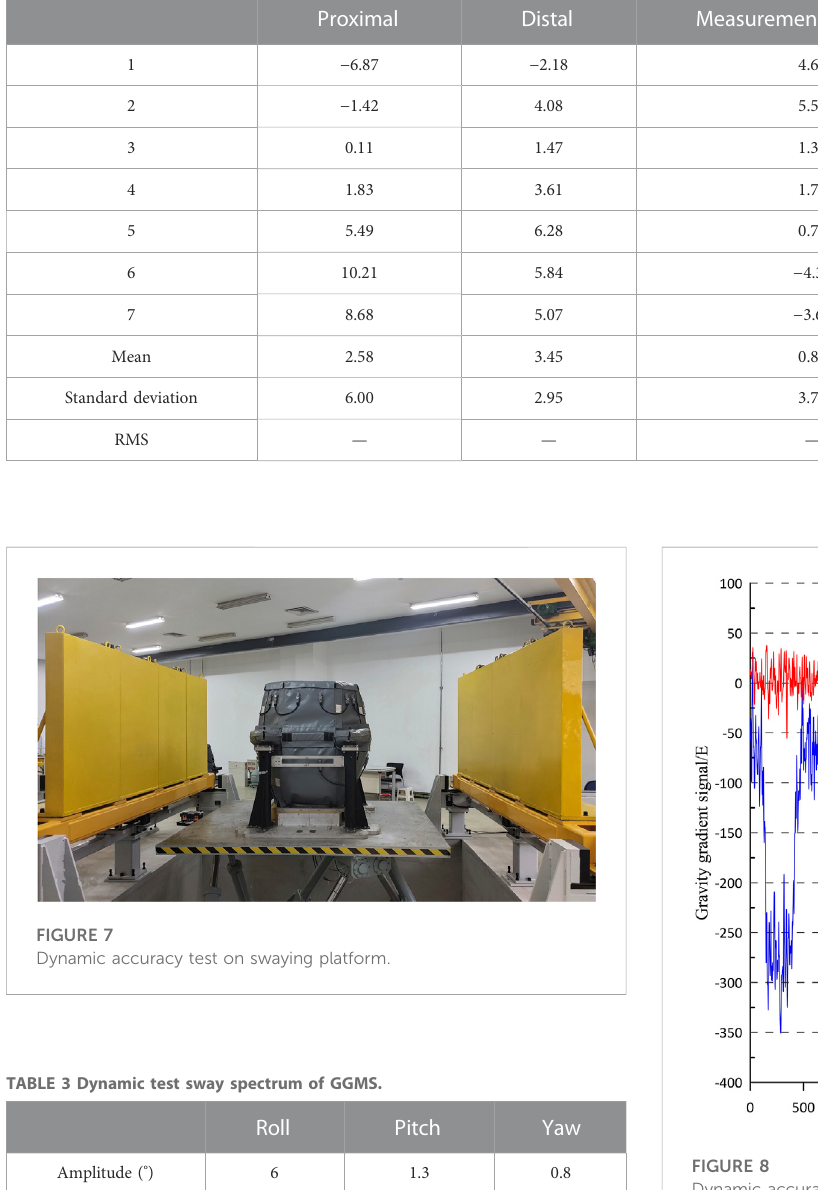
FIGURE 8 Dynamic accuracy test curve of